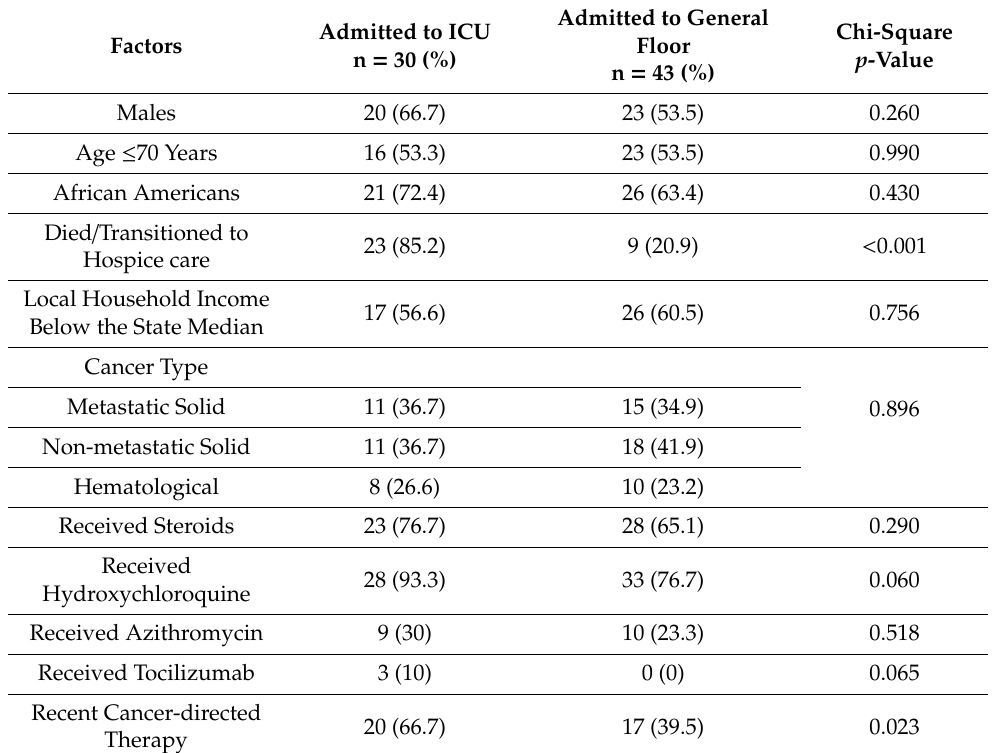
Table 4. Baseline characteristics of hospitalized patients (n = 73) based on admission to the intensive care unit